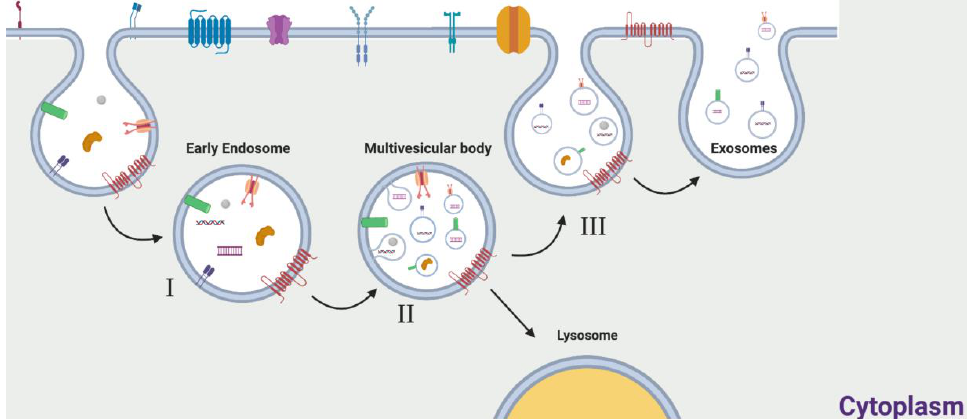
Figure 1. Schematic representation of exosome formation and release. Exosomal cargo from the extracellular and intracellular spaces is transported to early endosomes entering the endocytic pathway (I). During endosome maturation, the early endosomal membrane invaginates, leading to the formation of a late endosome, known as a multivesicular body (MVB), which is characterized by the presence of small, internal microvesicles. By this process, cargo is internalized into these microvesicles, now called exosomes (II). MVBs preferentially fuse with lysosomes, for the degradation of cellular components (III), or can fuse with the cytoplasmic membrane, allowing the release of the exosomes into the extracellular space